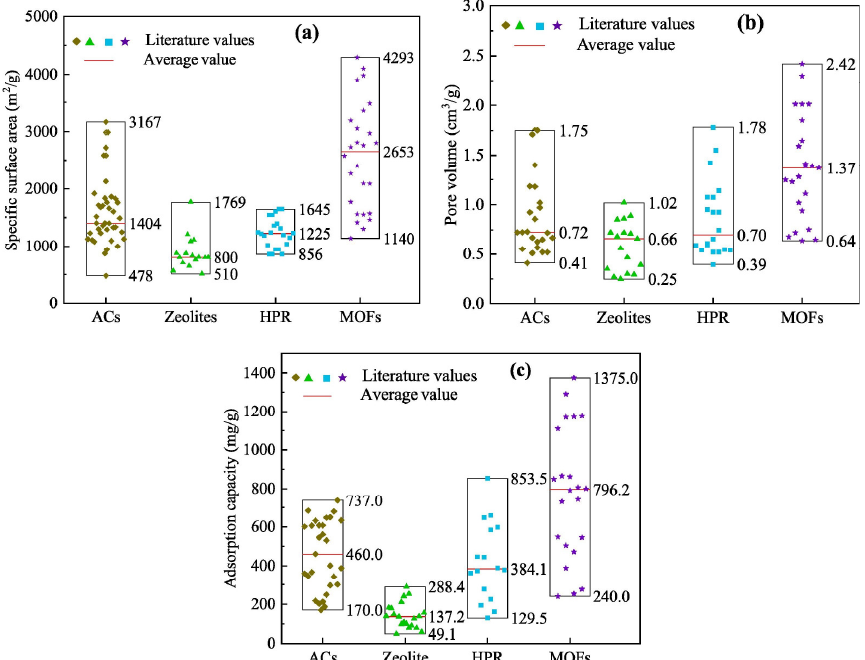
Figure 15. Comparison of different adsorption materials (ACs; Zeolites; HPR; MOFs): ( a ) specific surface area; ( b ) pore volume; ( c ) adsorption capacity [77].